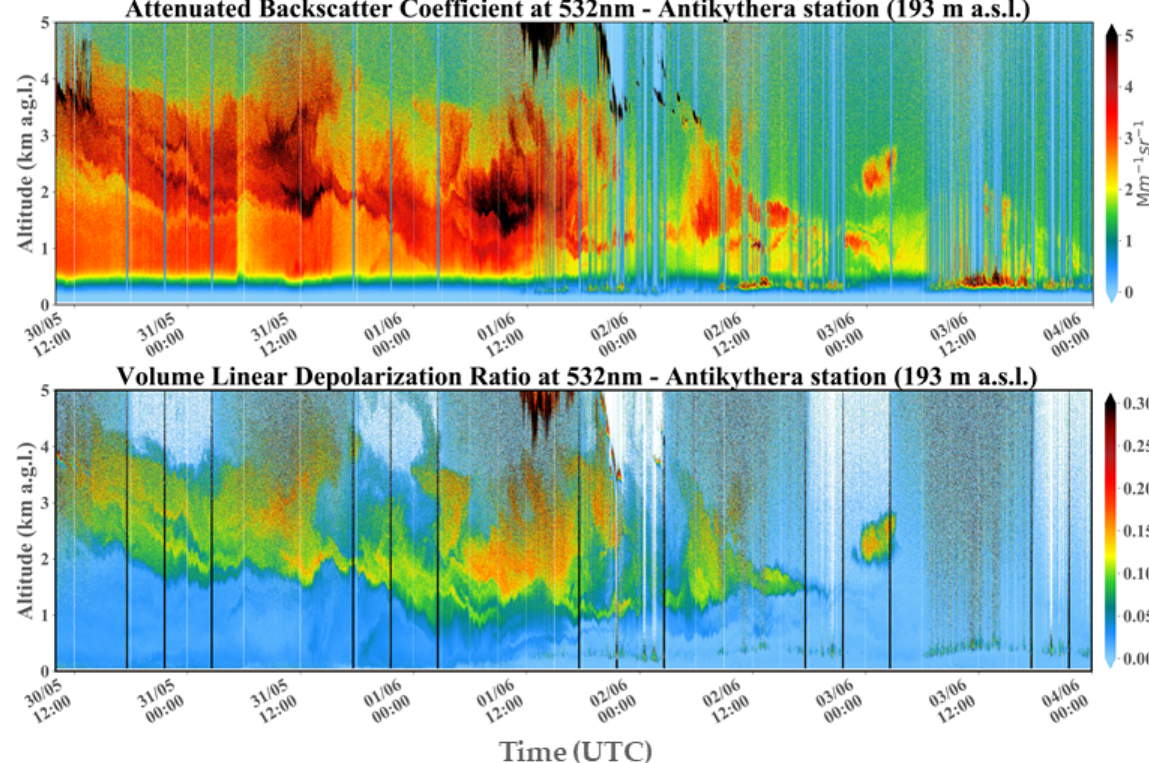
Figure 8. Attenuated backscatter at 532 nm ( up ) and volume linear depolarization ratio at 532 nm ( down ) at PANGEA station during 30 May 2019 (12:00 UTC) to 4 June 2019 (00:00 UTC). Station elevation is at 193 m